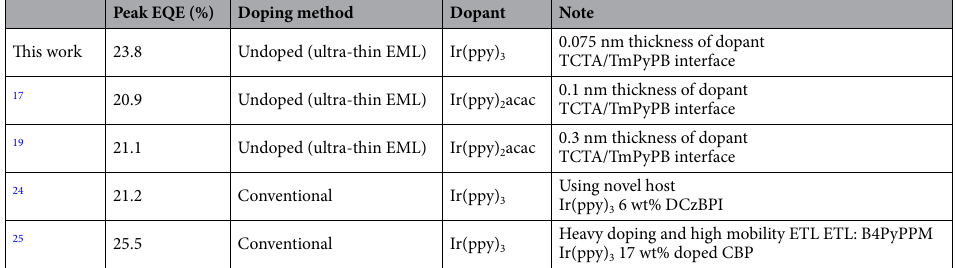
Table 2. Summary of peak EQE in this study and in previous